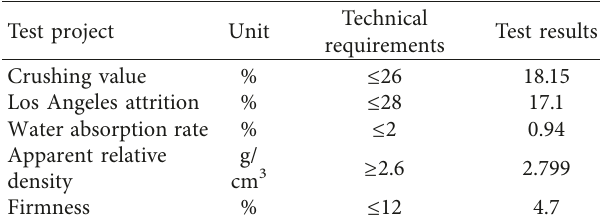
Table 2: Performance index of coarse